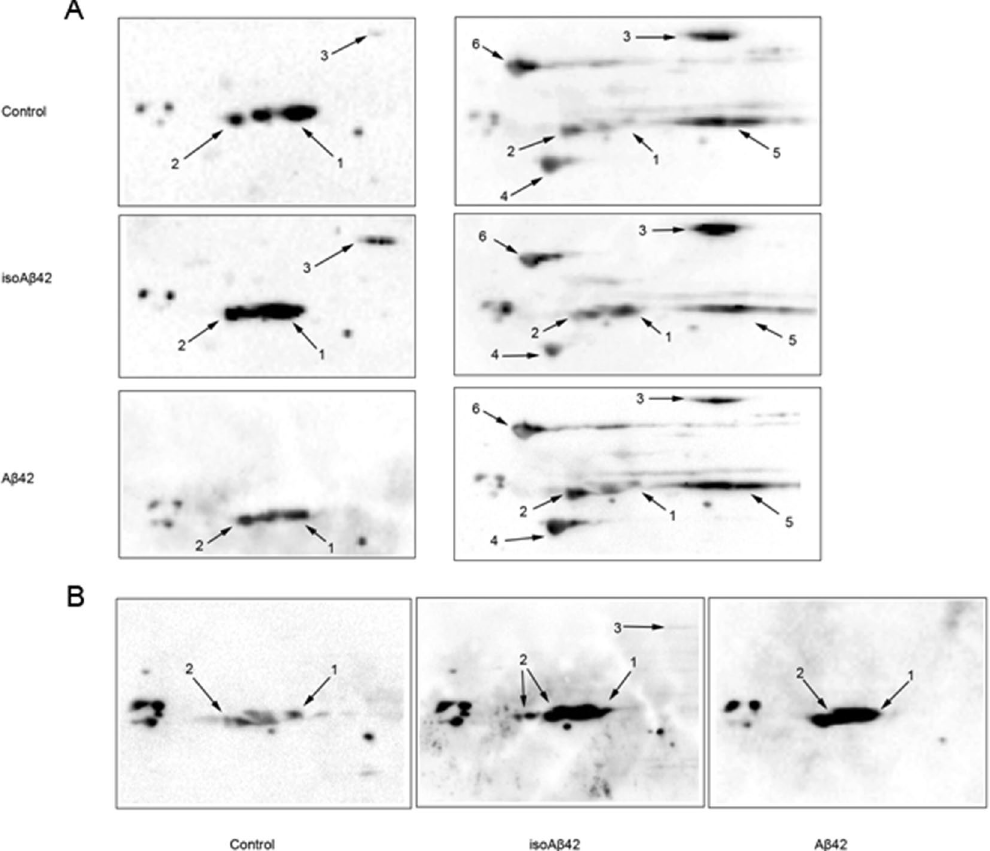
Figure 5. Western blot analysis of 2D-gels from SH-SY5Y control cells and SH-SY5Y cells treated with A β 42 and isoA β 42 (10 μ M, 6 h). ( A ) A merged image of anti-actin, anti-matrin 3, anti-total tau, anti- β -tubulin, anti- α -tubulin and anti-HSP90 antibodies (1 - α -tubulin, 2 - β -tubulin, 3 - matrin 3, 4 - actin, 5 - total tau, 6 – HSP90). ( B ) Anti-phosphoserine antibodies (1 - α -tubulin, 2 - β -tubulin, 3 - HNRH1, 4 - matrin